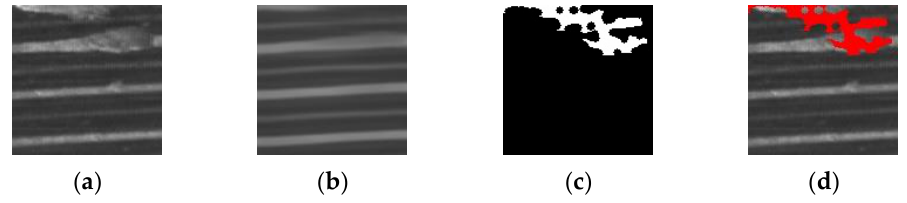
Figure 12. The meaning of the abnormal patch for two networks (unit: 0.03 mm/pixel). ( a ) Original patch image; ( b ) reconstruct patch image; ( c ) residual patch image; ( d ) superimposed patch image.